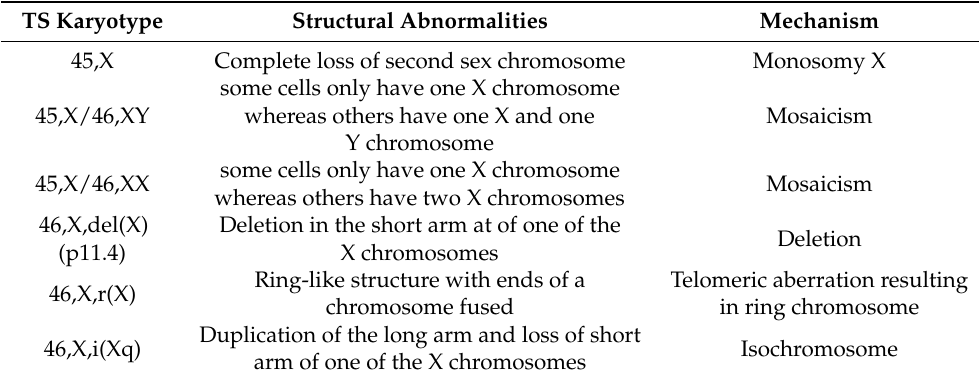
Table 1. TS karyotypes and description of associated structural